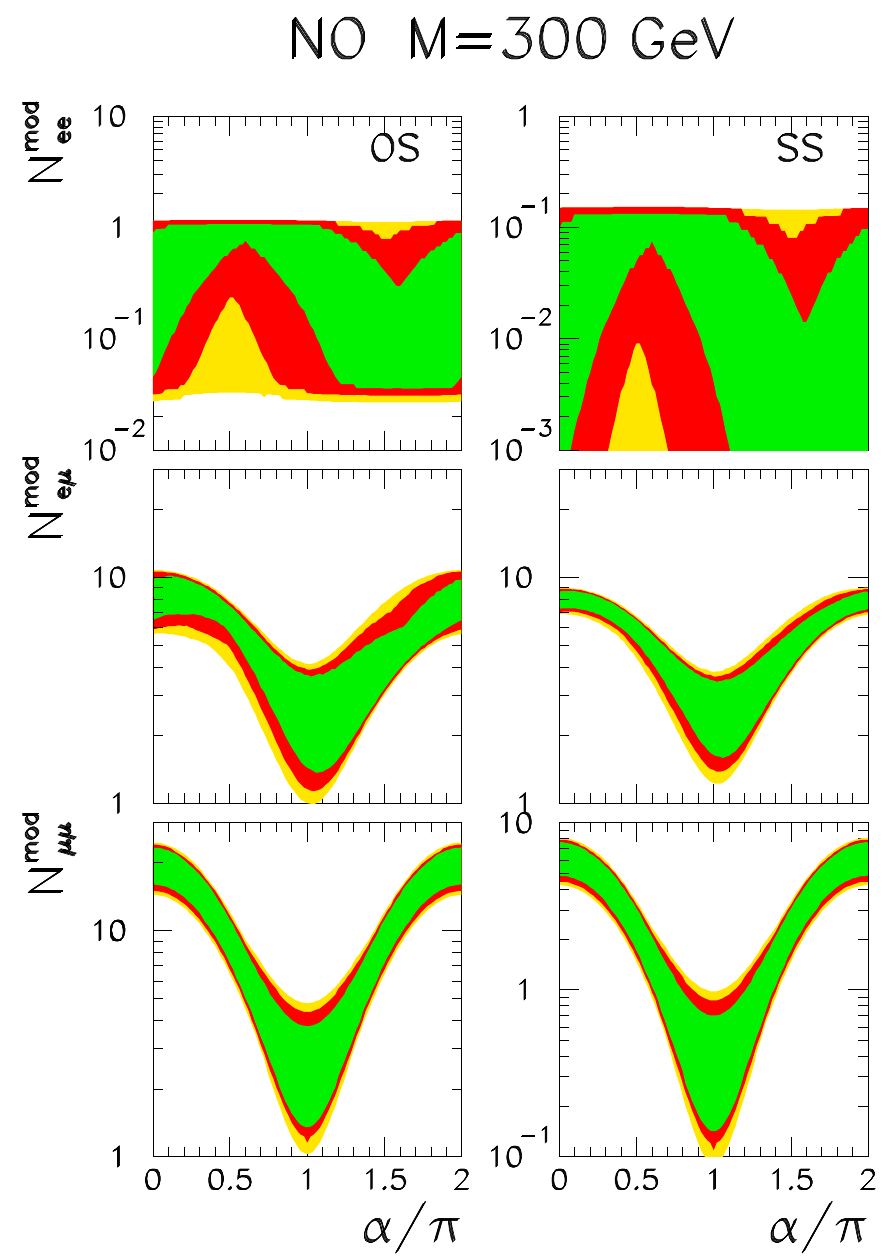
p Figure 3 . Expected number of signal events at s = 8 TeV and an integrated luminosity of 20.3 fb (cid:0) 1 , in each of the six (cid:13)avour-charge combinations for a triplet mass of M = 300 GeV and for neutrino parameters corresponding to the NO. The conventions are the same as in (cid:12)gure